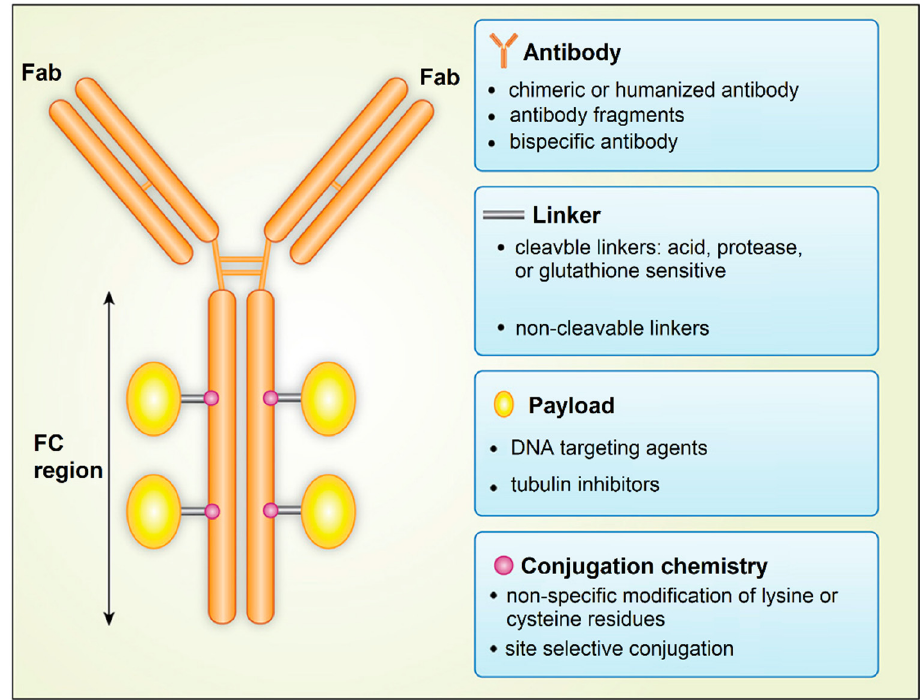
Figure 7. Schematic diagram showing the structure of the antibody drug conjugate. Adapted from